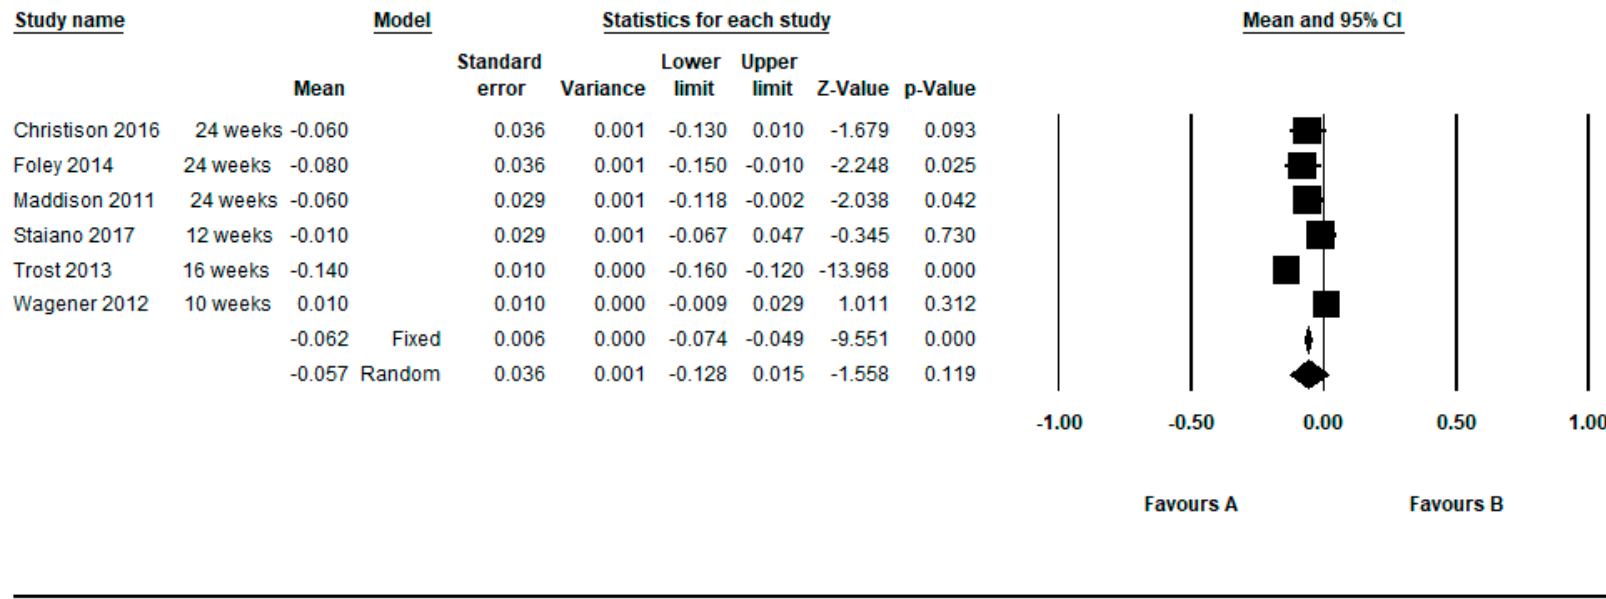
Figure 12. Pre-post difference of BMI between groups. Only BMI z-score in the longest follow-up.